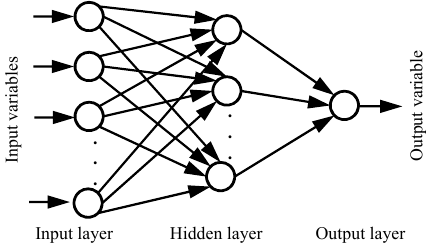
Figure 1. Schematic of artificial neural